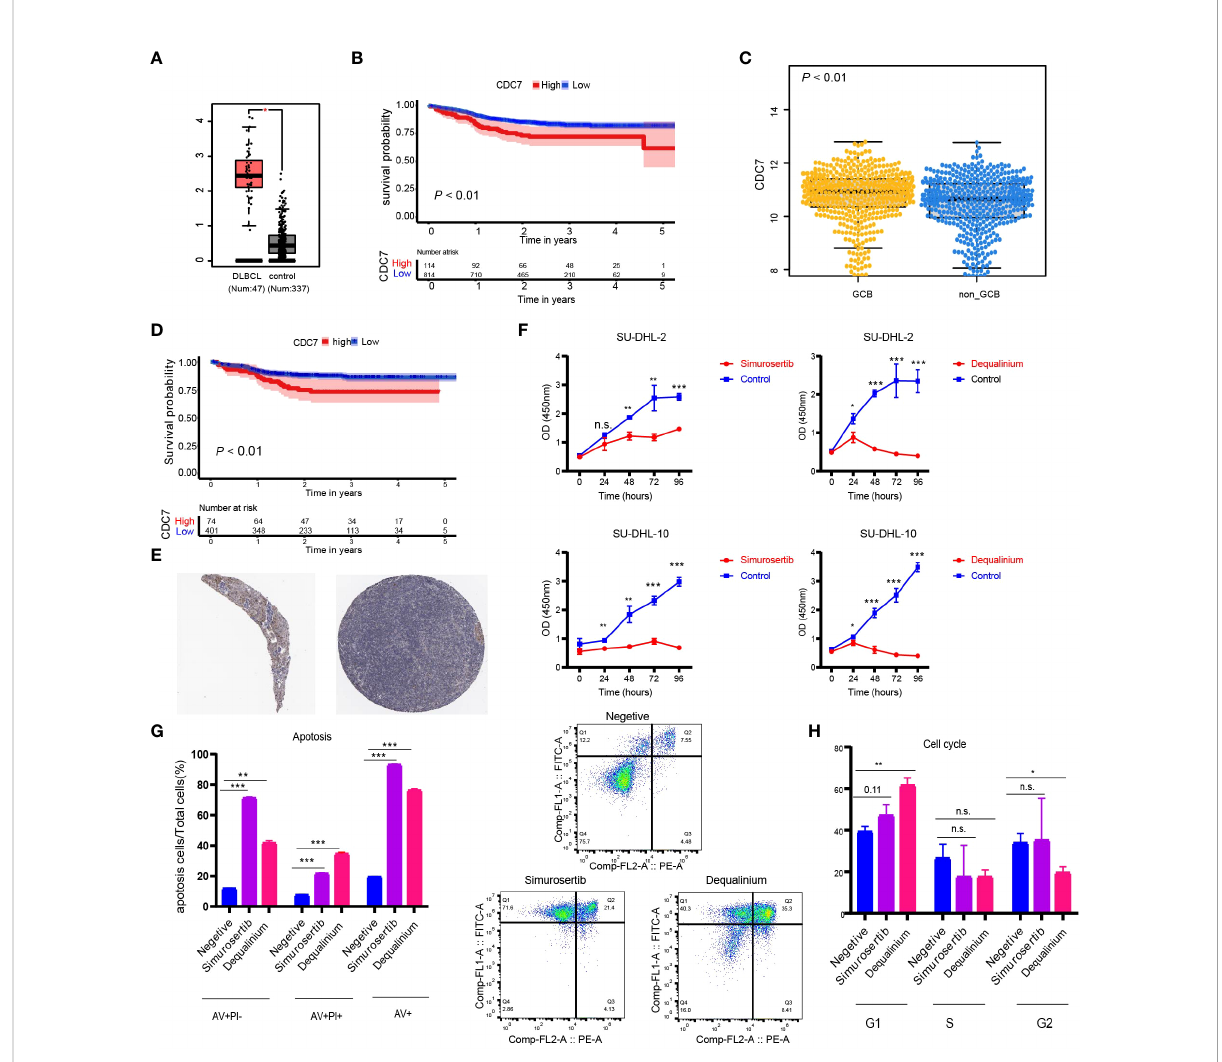
FIGURE 5 (A) Expression level of CDC7 in normal and lymphoma samples from the TCGA database; (B) Kaplan-Meier (K-M) curves of the expression of CDC7 ; (C) Boxplots of the expression of CDC7 in samples strati fi ed by ABC/GBC subtype; (D) Kaplan-Meier (K-M) curves of the expression of CDC7 for GCB cohort; (E) Immune histochemistry of CDC7 in normal lymph node; (F) Viability of SU-DHL-2 and SU-DHL-10 cells treated with dequalinium and simurosertib by IC 50 ; (G) Apoptosis ratio analysis of SU-DHL-10 cells treated with dequalinium and simurosertib for 48 h; (H) cell cycle analysis of SU-DHL-10 cells treated with dequalinium and simurosertib for 48 h. Data are means ± standard deviation (SD) of triplicate experiments. Dequalinium and simurosertib compared with the control using unpaired t-tests (* P < 0.05, ** P < 0.001, and *** P < 0.0001). n.s., no signi fi